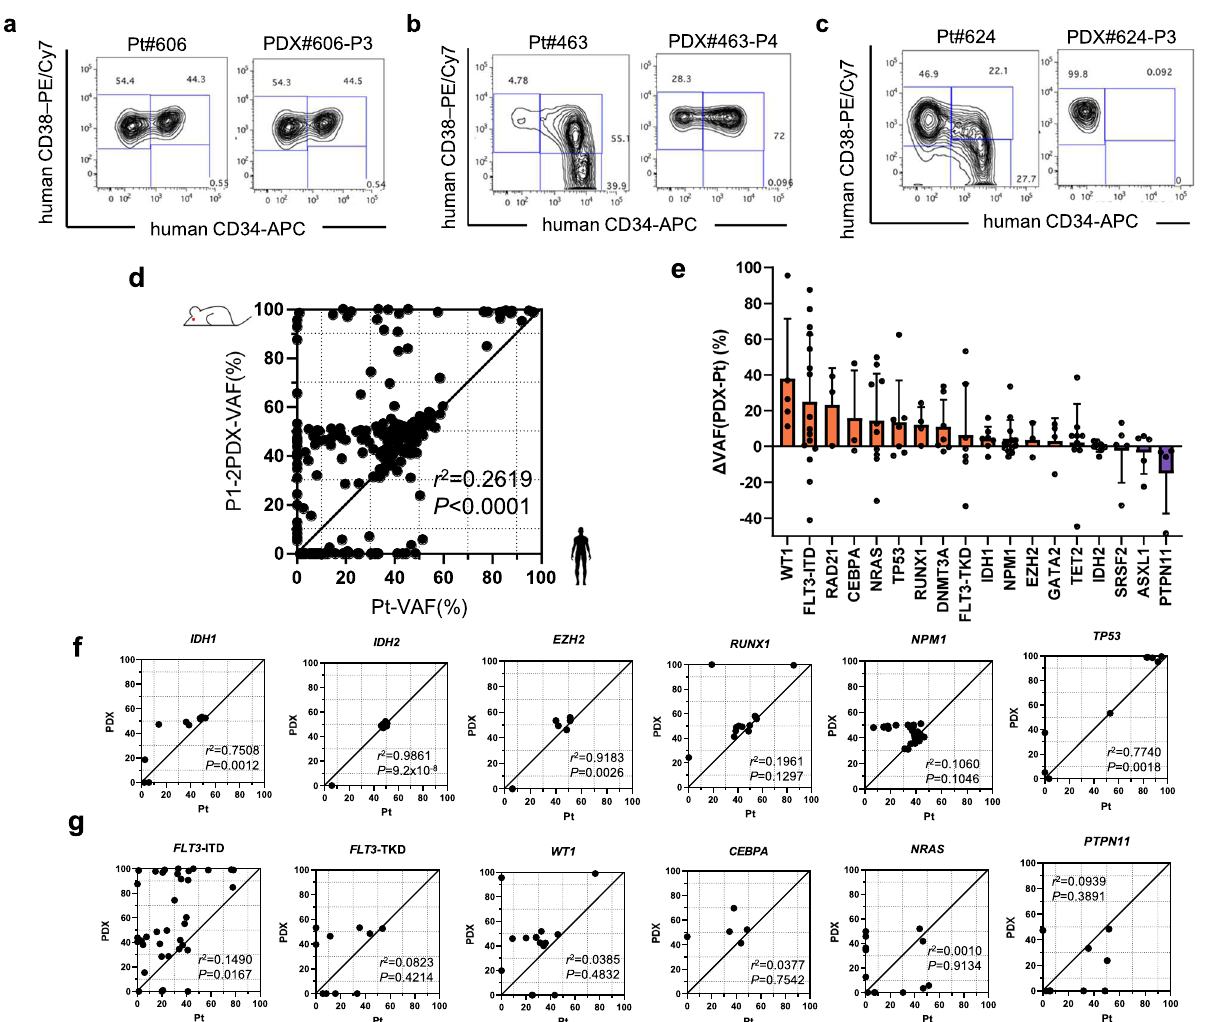
Fig. 2 Diversity in molecular phenotypes between primary AML and their corresponding PDX models. a – c Flow cytometric analysis of hematopoietic stem cells by the expression of CD34 and CD38 in representative pairs of primary AML patients and AML-PDX models. d Scatter plots showing the variant allele frequencies (VAF) relationship between primary AML cells and P1-2 PDX BM cells. Every dot represents each single genetic alteration. R 2 value and two-tailed P -value calculated using Pearson ’ s correlation indicate the strength and signi fi cance, respectively, of the relationships. e Waterfall plots show changes in VAF between primary AML and PDX. Genes in which mutations were detected in more than three patients are shown ( WT1, n = 5; FLT3 -ITD, n = 16; RAD21 , n = 3; CEBPA , n = 3; NRAS , n = 10; TP53 , n = 7; RUNX1 , n = 4; DNMT3A , n = 7; FLT3 -TKD, n = 7; IDH1 , n = 7; NPM1 , n = 13; EZH2 , n = 3; GATA2 , n = 4; TET2 , n = 9; IDH2 , n = 8; SRSF2 , n = 5; ASXL1 , n = 5; PTPN11 , n = 4 biologically independent samples). Bars, median; Error bars, standard deviations. f Scatter plots of VAF relationships between primary AML cells and P1-2 PDX BM cells in genes with strong correlations. g Scatter plots of VAF relationships between primary AML cells and P1-2 PDX BM cells in genes with weak correlations. R 2 values and two-tailed P -values calculated using Pearson ’ s correlation indicate the strength and signi fi cance, respectively, of the relationships. Source data are provided as a Source Data fi patients, we evaluated serial clonal dynamics in 21 newly diag- nosed AML patients by analyzing patient samples at diagnosis and R/R and each corresponding PDX model (Supplementary Table 5). Dominant clones were identi fi ed from the VAF of each variant in each sample. Of note, selectively expanded subclones in PDX generated from AML samples at diagnosis (Diagnosis-PDX) were predictively consistent with the dominant clones at R/R in 12 out of 21 (57%) patients (Fig. 6 and Supplementary Fig. 5). Patient #28 had subclones carrying RUNX1 R107HWR (VAF, 38.8%) and WT1 C453Y (VAF, 20.0%) and/or IDH1 R132H (VAF, 5.9%) at the diagnosis of AML-M2 (Fig. 6a). The number of clones carrying the IDH1 R132H mutation was smaller in the Diagnosis-PDX model than in this patient ’ s sample, whereas clones carrying the 15-bp insertion of the FLT3 -ITD mutation, which was not detected in the patient ’ s BM sample at diagnosis,